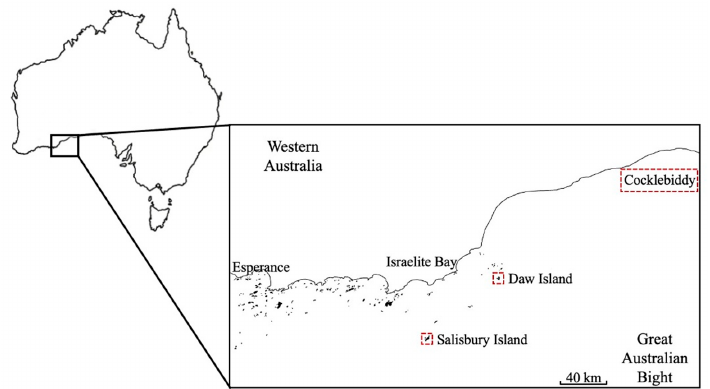
Figure 1. Maps illustrating the study sites. Bycatch data from a commercial gillnet fisherman target- ing gummy sharks ( Mustelus antarcticus ) were collected from a site near Cocklebiddy, Western Aus- tralia (32°16 ′ S, 126°17 ′ E). This site is characterized by having a sandy seafloor and low visibility conditions. Opportunistic video sampling was conducted in Recherche Archipelago [Salisbury Is- land (34°21 ′ S, 123°32 ′ E) and Daw Island (33°51 ′ S, 124°08 ′ E)]. These sites varied in depth and bath- ymetric structure—from rocky reefs dominated by golden kelp ( Ecklonia radiata ) to sand flats dom- inated by various seagrass (e.g., Posidonia australis